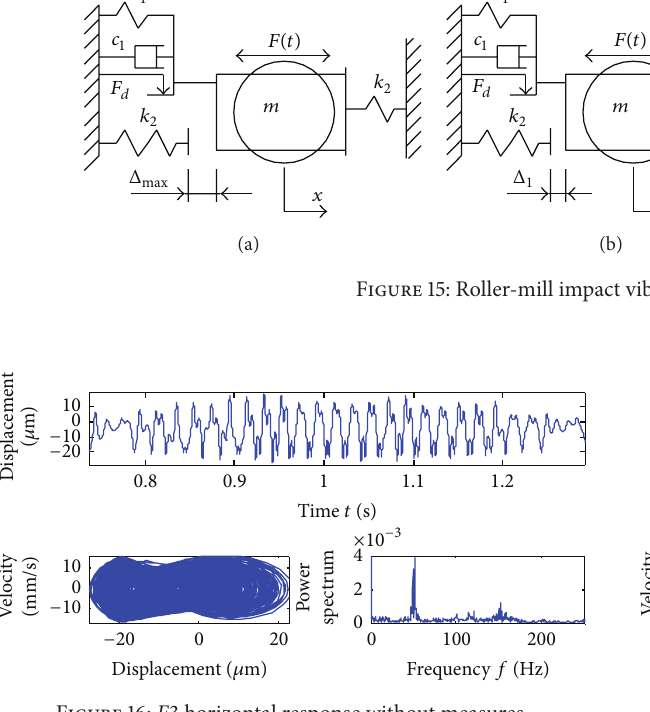
Figure 16: F 3 horizontal response without measures. Figure 17: F 3 horizontal response with